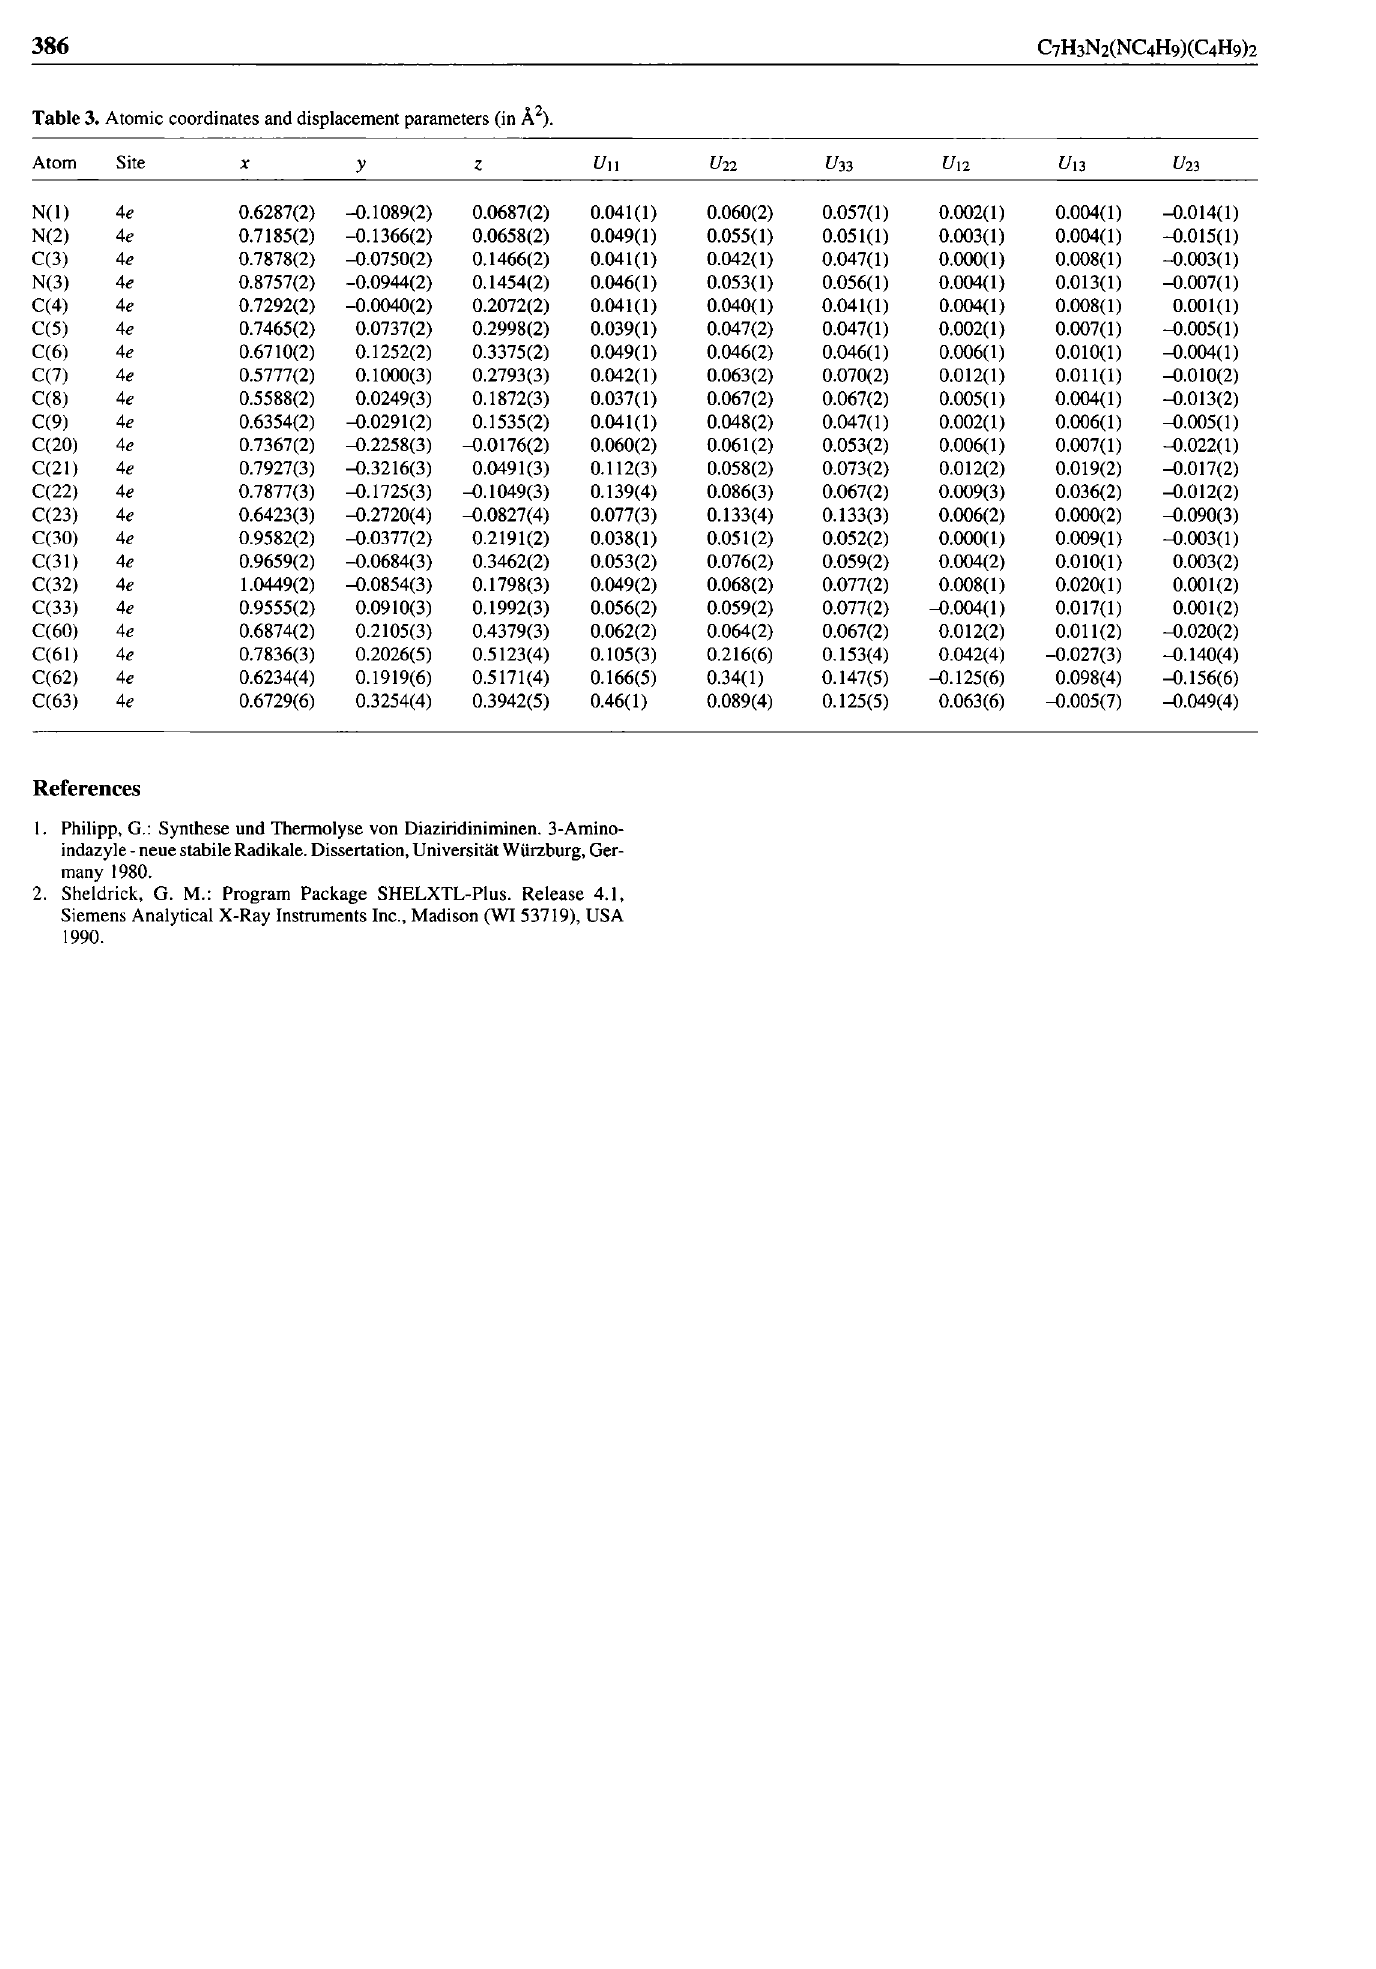
Table 3. Atomic coordinates and displacement parameters (in Ä 2